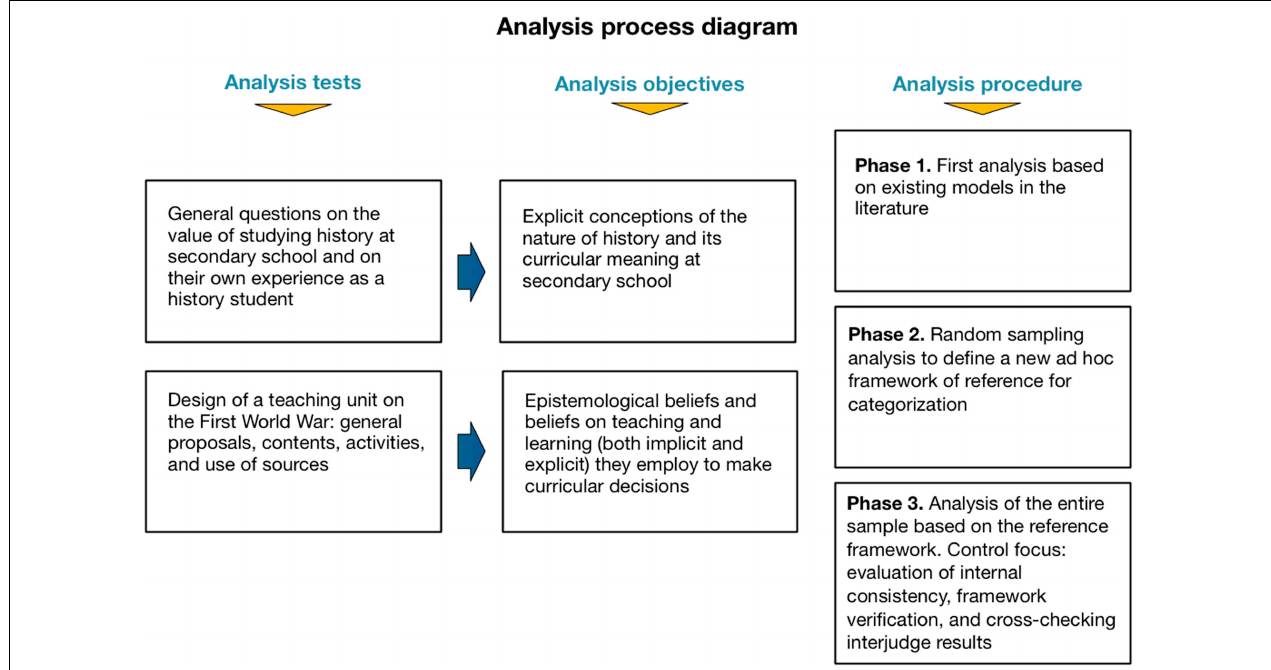
FIGURE 1 | Flow chart of objective tests and analysis phases. Compiled by the